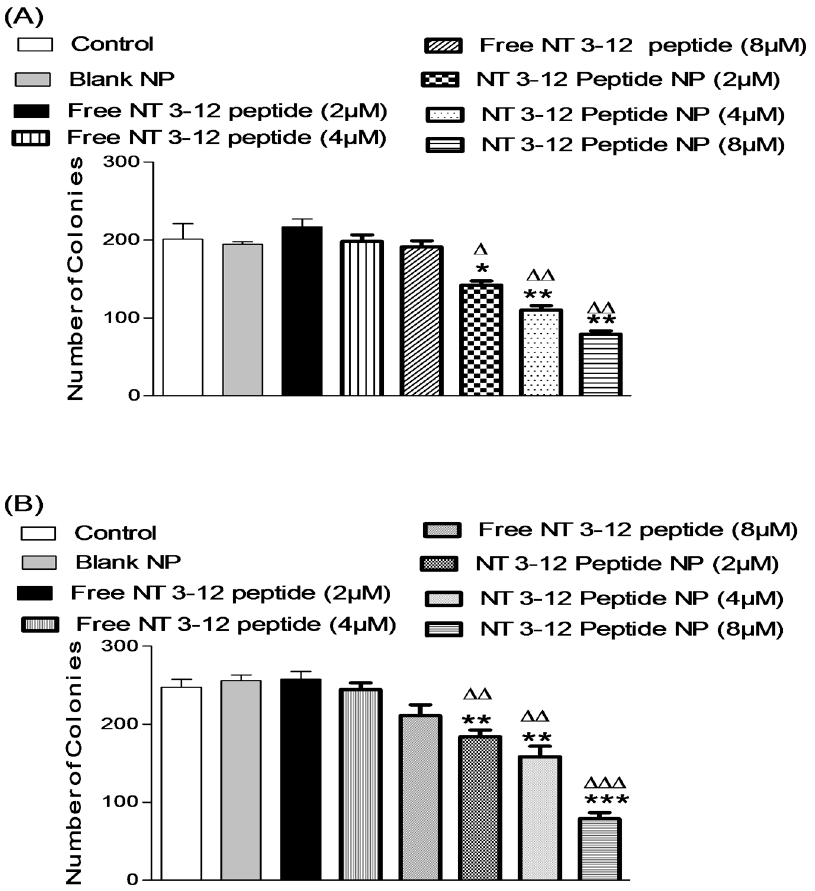
Figure 7. Effect of different doses of free N 3–12 peptide and N 3–12 peptide-loaded NPs on MDA-MB-231 number of colonies ( A ) and A549 number of colonies ( B ). Values are mean ± SEM with n = 3. * p < 0.05, ** p < 0.01, *** p < 0.001 compared with Control and blank NP. Δ p < 0.05, ΔΔ p < 0.01, ΔΔΔ p < 0.001 compared with the same dose of free peptide.